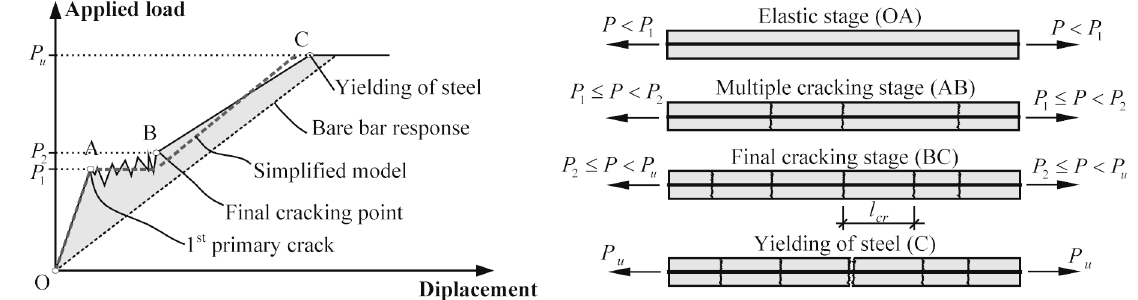
Fig. 1. Cracking stages of a tensile member